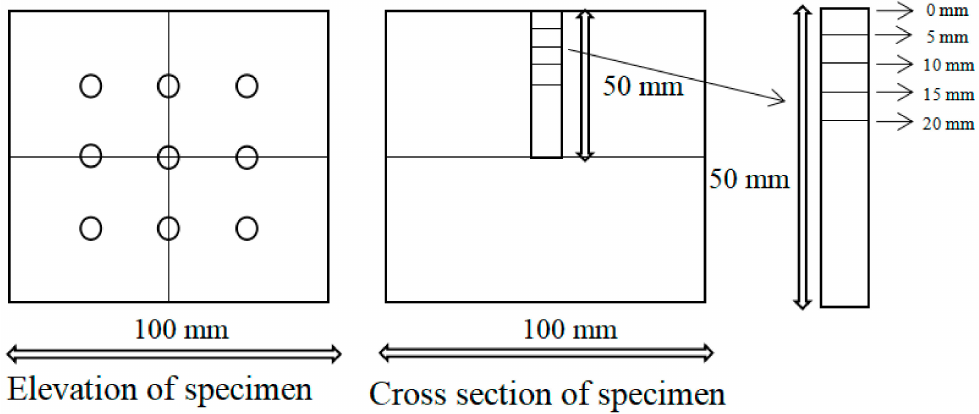
Figure 4. Sampling process